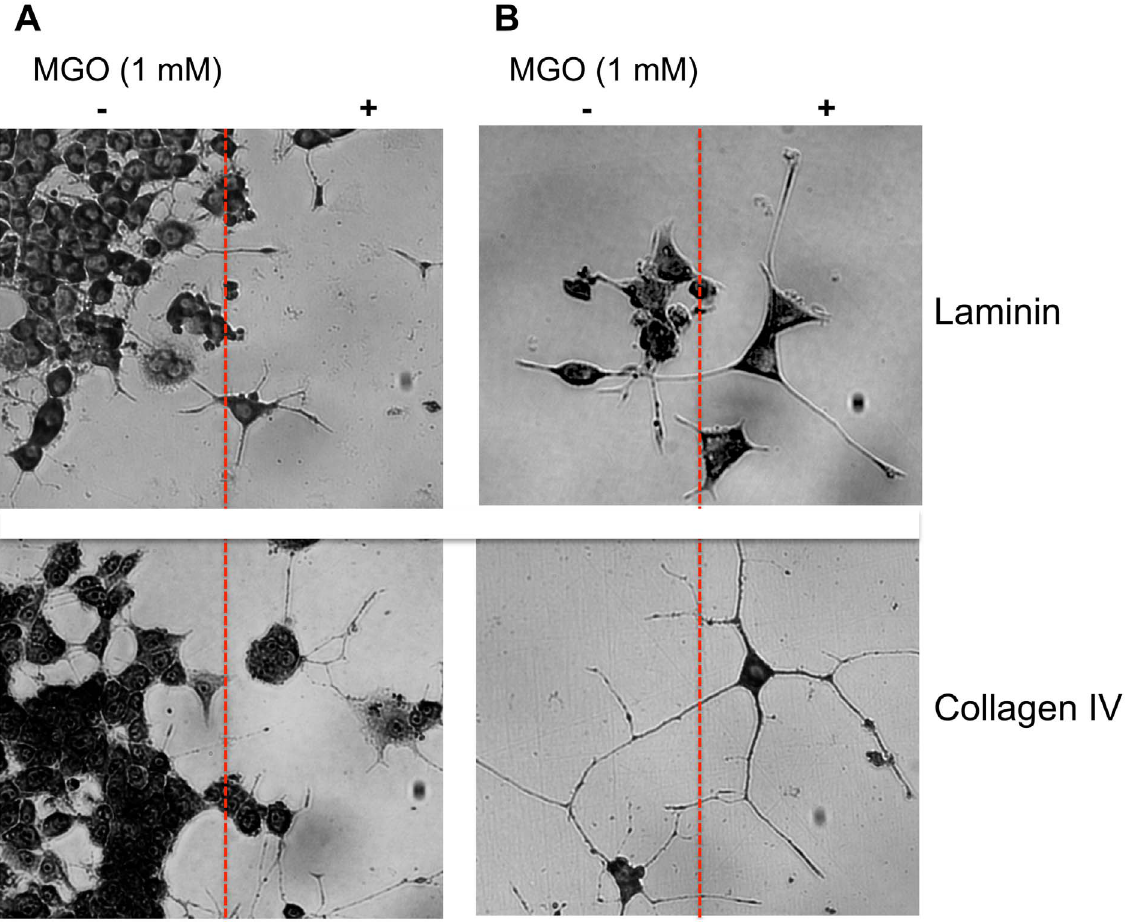
Figure 4. Cell adhesion and neurite outgrowth at the border of AGE-modified ECM proteins. A. Representative micrographs of PC12 cells taken at the border (red line) of AGE-modified or non-AGE-modified laminin or collagen IV coated cell culture plates. Three independent experiments were performed. Note that PC12 cells prefer non-AGE-modified laminin or collagen IV. B. Representative micrographs of neurite outgrowth at the border of AGE-modified or non-AGE-modified laminin or collagen IV coated cell culture plates. Three independent experiments were performed. Note that neurite outgrowth of PC12 cells was not different between non-AGE-modified laminin or collagen IV or AGE-modified laminin and collagen IV.